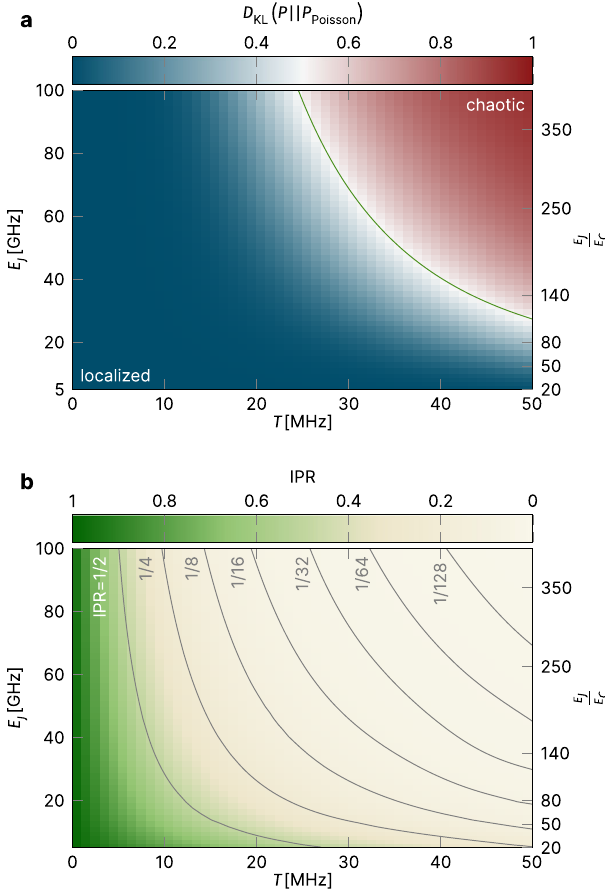
Fig. 4 Phase diagrams. a summarizes the spectral statistics by plotting the Kullback – Leibler divergence D KL with respect to the Poisson distribution in the plane spanned by the Josephson energy E J and the transmon coupling T for scheme- A parameters. One identi fi es an MBL regime (blue) for small couplings and a quantum-chaotic regime (red) following Wigner – Dyson statistics for large couplings. b summarizes the wave function statistics for the same parameters by color-coding the inverse participation ratio (IPR) showing a fast drop to values below 1/2 already for moderate coupling strength. The gray lines indicate contour lines of constant IPR. All results are averaged over at least 2000 disorder realizations. The spread of the Josephson energies varies from δ E J ∼ 0.4 GHz for E J = 5 GHz to δ E J ∼ 1.7 GHz for E J = 100 GHz (see Methods for